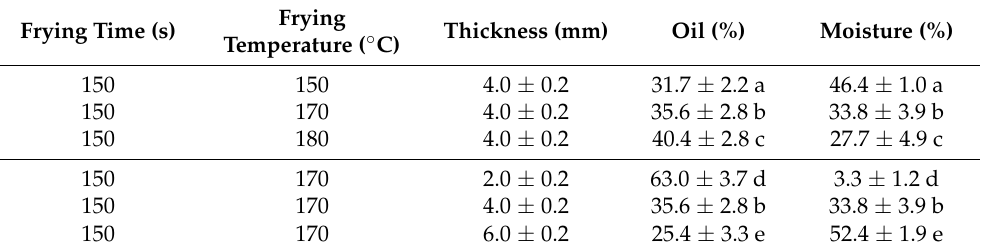
Table 3. Effect of frying temperature and slice thickness in final oil and moisture content of whole uncoated mushroom